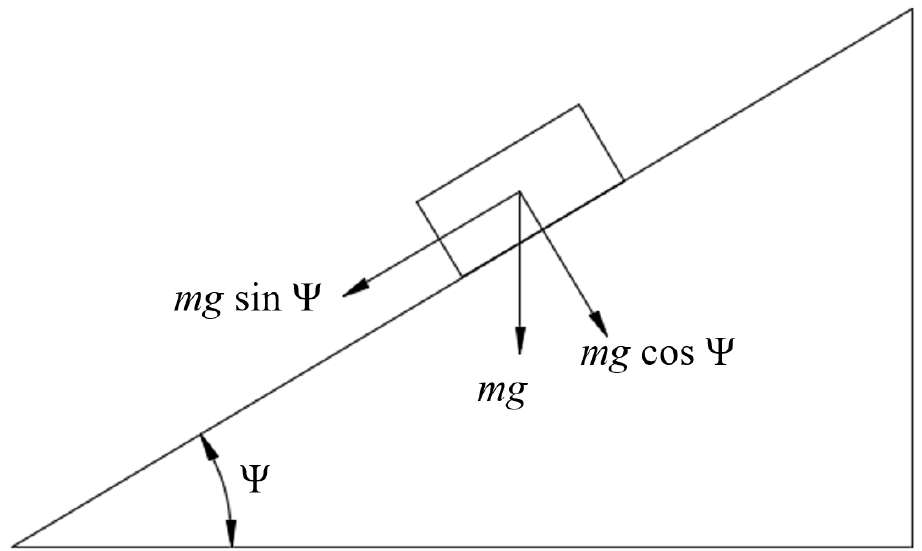
Figure 10. Schematic diagram of inclined plane test setup with a block [97] for static friction coeffi- cient. A ball can be used as well for rolling friction coefficient as found in Ucgul et al. [29].